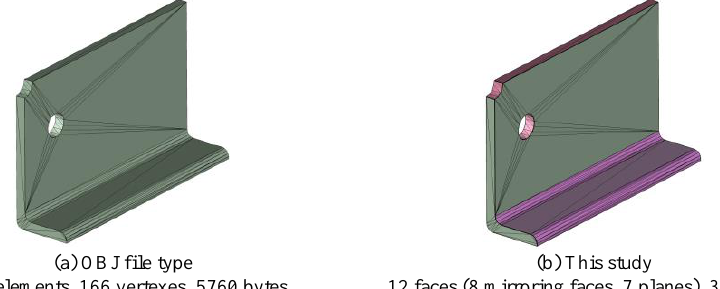
Figure 16. Data size comparison for L-shaped beam.